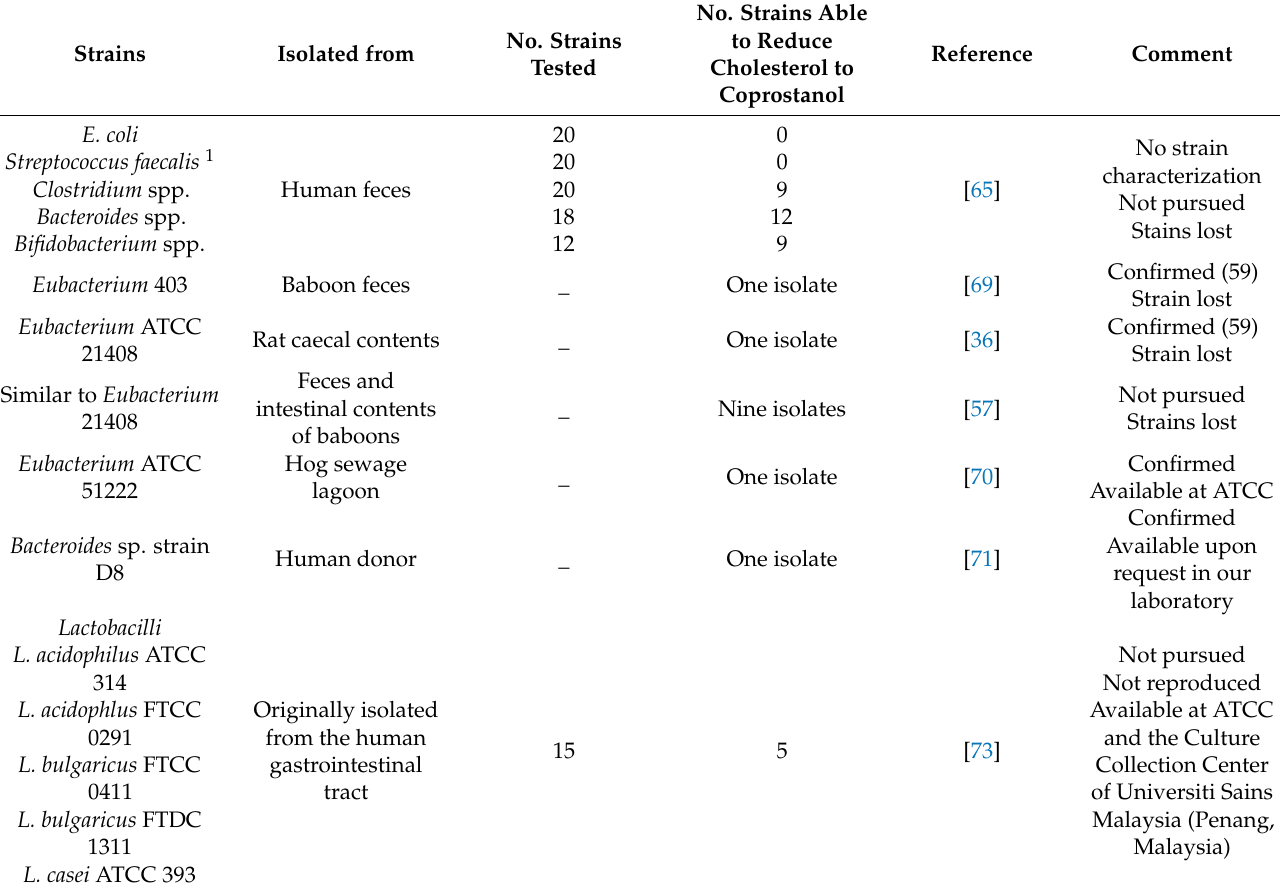
Table 1. Isolated active